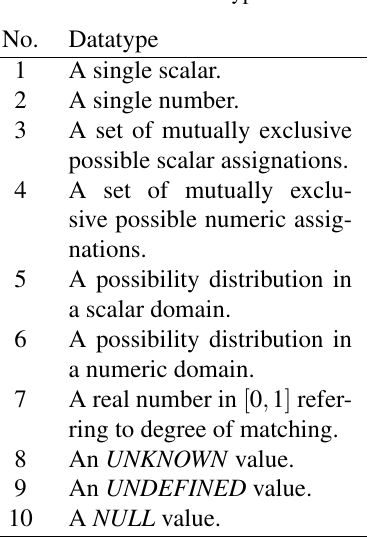
Table 10. Data types